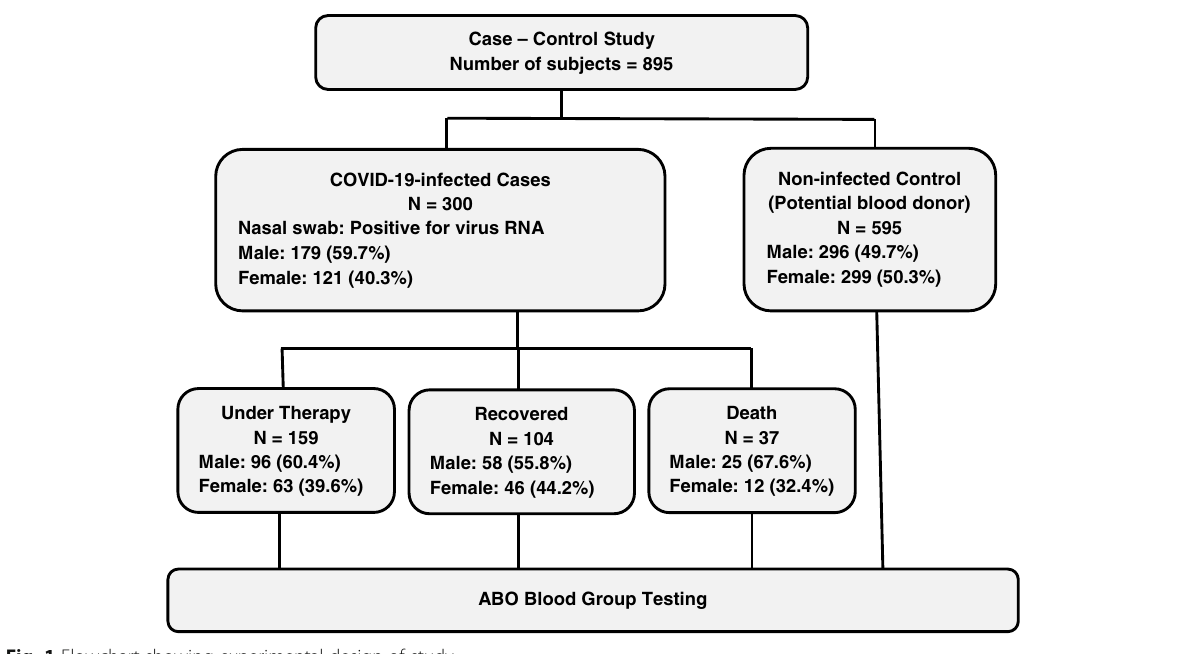
Fig. 1 Flowchart showing experimental design of study